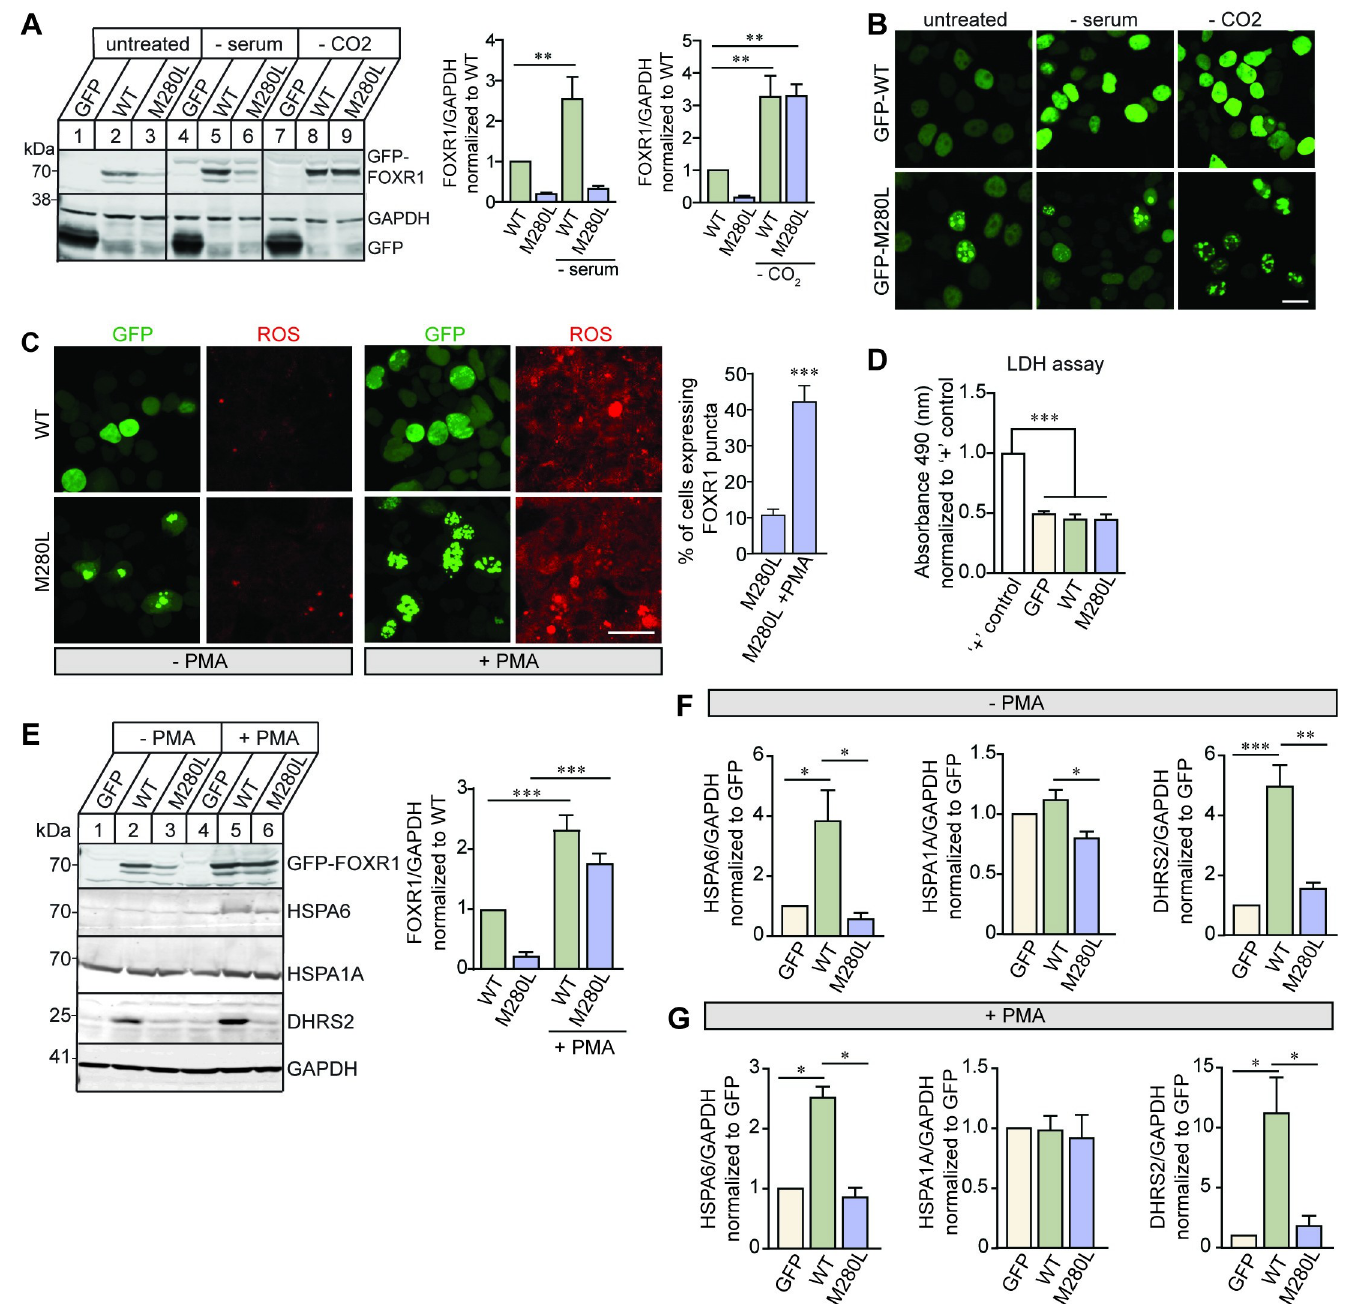
Fig 6. FOXR1 expression is increased in response to cellular stress. (A) Representative immunoblots and quantitative analysis for FOXR1 from HEK293T cells transfected with GFP, GFP-tagged FOXR1 WT or M280L mutant in response to serum and CO 2 deprivation. GAPDH served as loading control. Graph represents FOXR1 over GAPDH normalized to untreated WT. One-way ANOVA Tukey’s multiple comparisons test (n = 4 independent experiments, �� p < 0.0051). (B) Fluorescence images of HEK293T cells transfected with GFP-tagged human FOXR1 WT or M280L in response to serum and CO 2 deprivation. Scale bar = 20 μ m. (C) Fluorescence images of HEK293T cells transfected with GFP-tagged human FOXR1 WT or M280L and treated with PMA, a NADPH oxidase activator known to enhance reactive oxygen species (ROS). Cells were fixed after 24 hours of treatment and assessed for ROS generation using CellROX, a photostable ROS sensor. Scale bar = 20 μ m. Quantitative analysis of the percentage of cells expressing FOXR1 puncta phenotype. Unpaired t -test (n = 4 independent experiments, ��� p < 0.0001). (D) Lactate dehydrogenase (LDH) levels from conditioned media of HEK293T cells following PMA treatment. Positive control is a set of cells treated with the lysis buffer. Data are expressed based on the absorbance reading at 490 nm normalized to positive control. One-way ANOVA Tukey’s multiple comparisons test (n = 3 independent experiments, ��� p < 0.0001). (E) Representative immunoblots and quantitative analysis of HEK293T cells following PMA treatment showing an increase in FOXR1 expression. Graph represents FOXR1 over GAPDH normalized to untreated WT. One-way ANOVA Tukey’s multiple comparisons (n = 5 independent